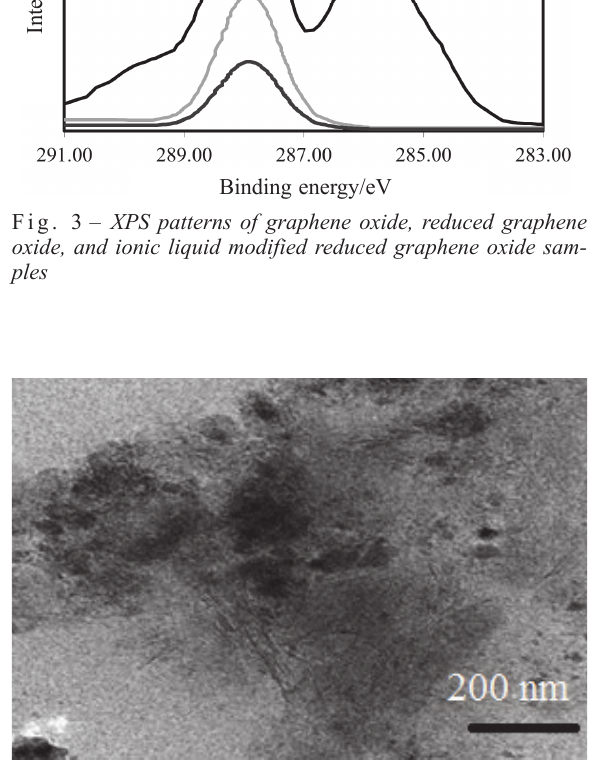
Fig. 4- Fig. 4 – TEM image of ionic liquid modified reduced